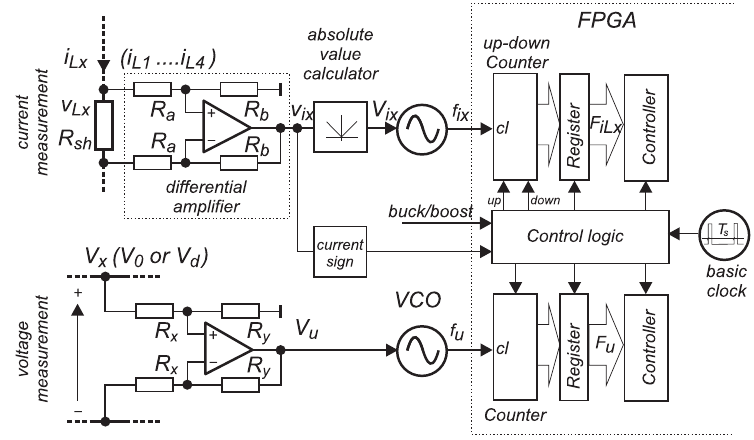
Figure 4. Measurement chain for inductor-currents ( i L 1 ... i L 4 ), input and output voltages ( V 0 and V d ) performed by